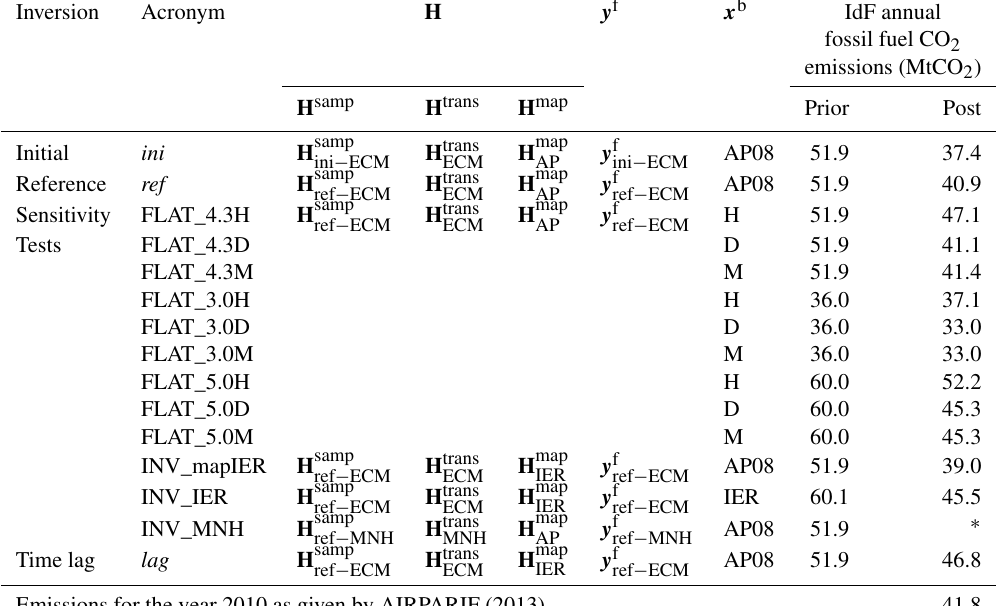
Table 1. Summary of the different inversion configuration and Île-de-France (IdF) annual fossil fuel CO 2 emissions from different inventories and inversion results. Priors that are flat at the monthly, daily and 6-hourly scale are denoted M, D and H, respectively (see Sect. 2.6 for the details). Posterior estimates are derived from inversions using the operator and prior estimate indicated in the corresponding line of the table.